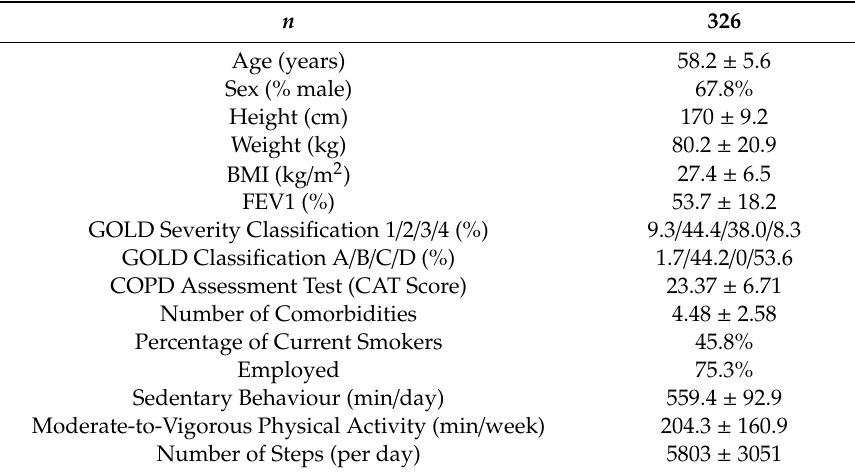
Figure 1. Flow chart for the analysis. Table 1. Characteristics of the whole